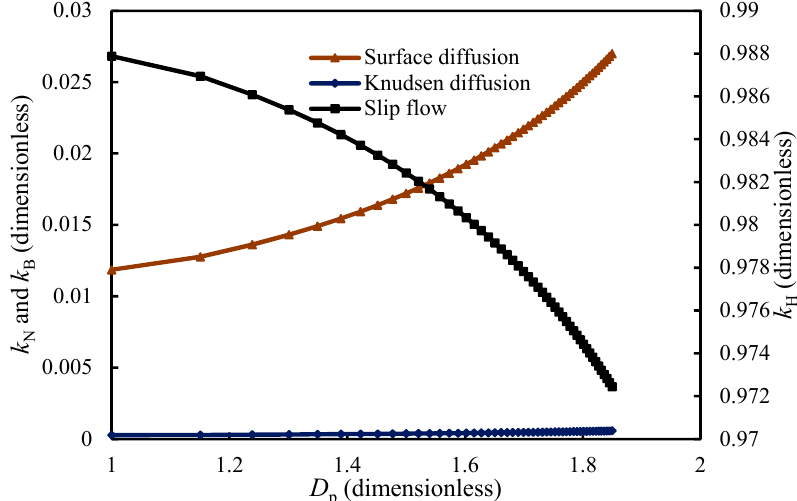
Figure 8. Relationship between contribution rate and fractal dimension of pore surface.